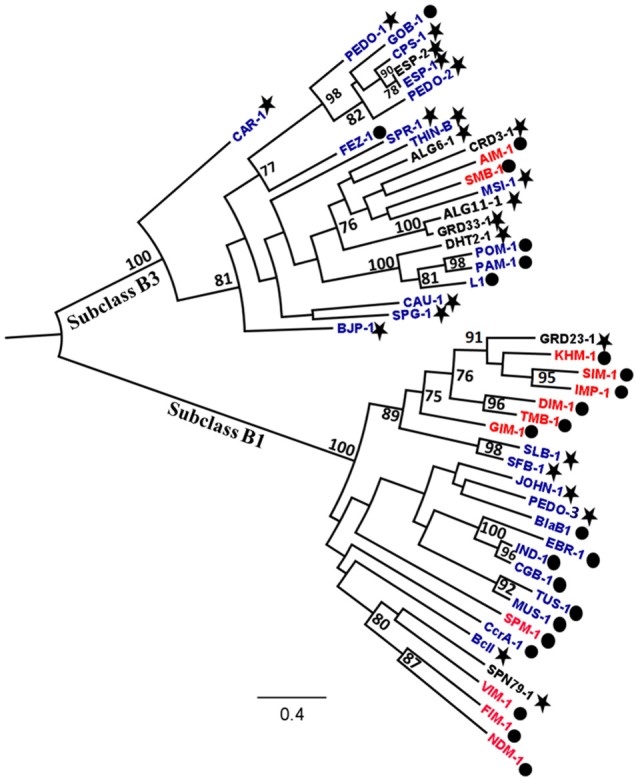
Mid-point rooted phylogenetic tree of subclass B1 and B3 metallo-ß-lactamases (MBLs). The evolutionary distances are expressed in unit of amino acid substitution per site. Bootstrapping support using 1000 replicates was applied and is indicated on branches where values are >70%. The new MBLs detected in this study are indicated in black while previously described acquired and resident MBLs are written in red and blue colors, respectively. The MBLs detected in clinical and environmental bacteria are indicated by a dot and a star, respectively.